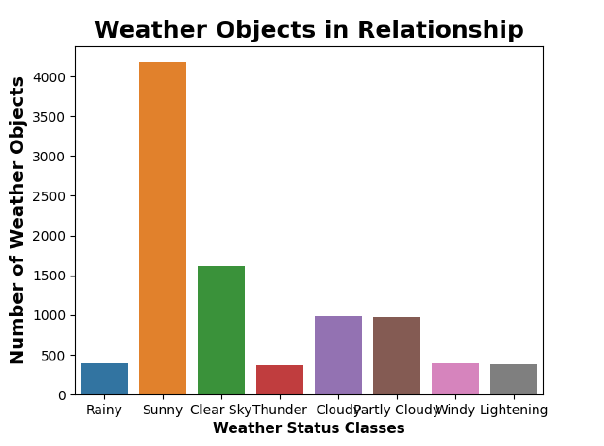
Figure 16. Street light objects in relationship.